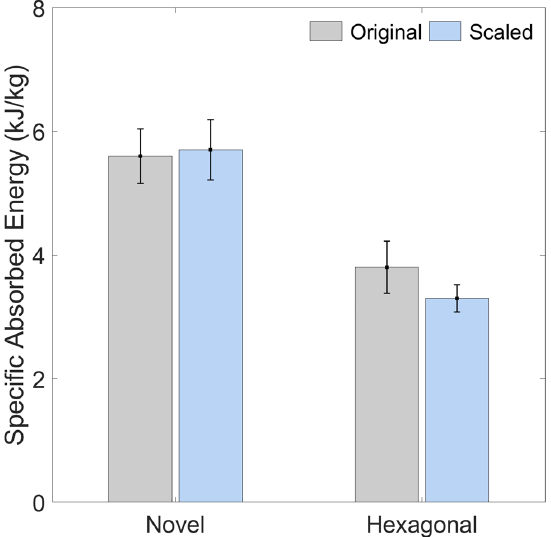
Figure 22. Average values (with standard deviations) of the experimentally measured energy absorption per unit mass, as a function of displacement under lateral load: comparison in terms of geometry and scale. The Scaled geometry is the larger one (having double dimensions compared to the original one).